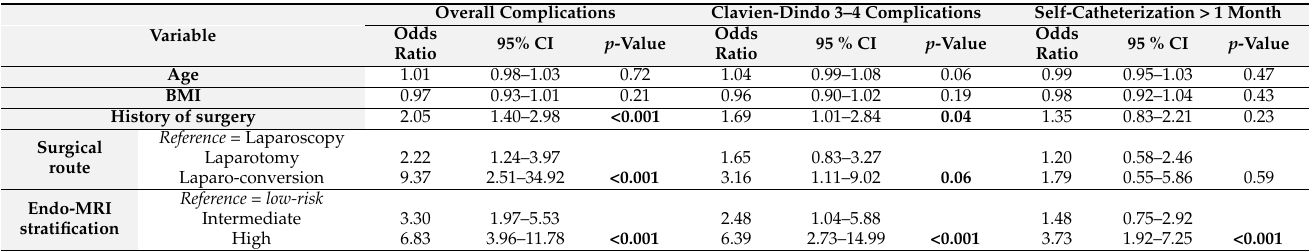
Table 5. Multivariate analysis of factors predicting the risks of post-operative complications. Overall